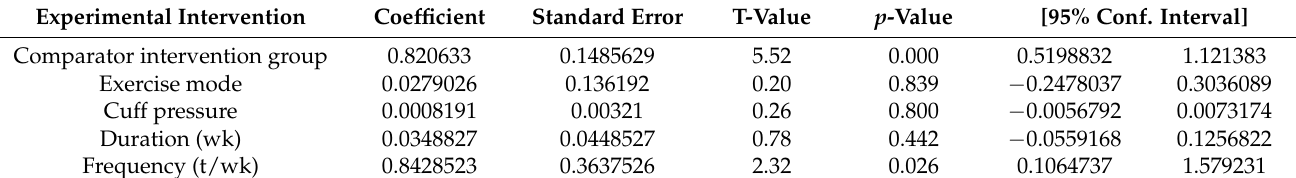
Table 2. Meta-regression analysis of the trial interventions.